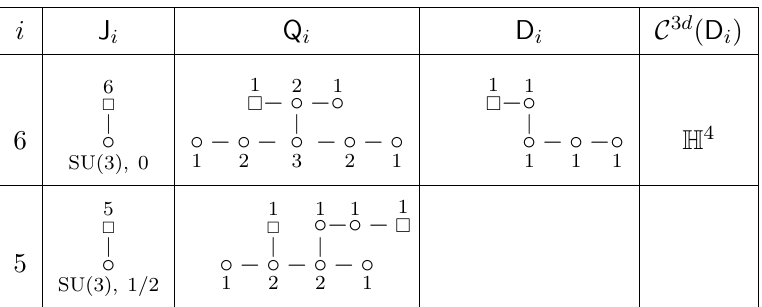
Table 4 . Quiver di(cid:11)erences between Higgs branches of 5 d theories at in(cid:12)nite coupling. J i are 5 d quivers. Q i are 3 d quivers such that H 1 ( J i ) = C 3 d ( Q i ) [41]. On the right, the quiver subtractions have been computed D i = Q i (cid:0) Q i (cid:0) 1